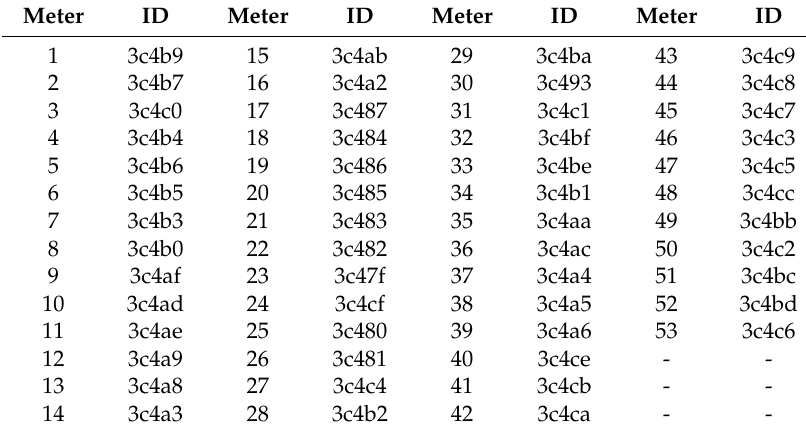
Table 4. Meter Number for the Actual Small-Scale PLC-based AMI.